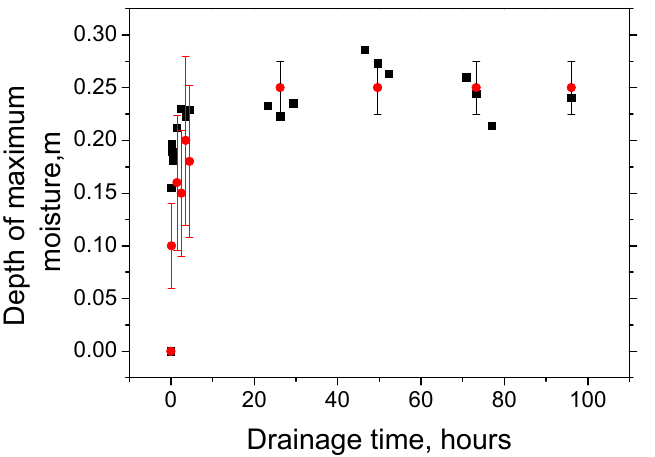
Figure 16. Experiment 1. Comparison of the depths of the sand layer with maximum moisture ( ● ) and the depths with maximum values of the derivatives of the relative reflectivity (Equation15) ( ■ ). The colored vertical bars show the scatter in measured sand moisture: red bars—±40%, black bars— ±10%.